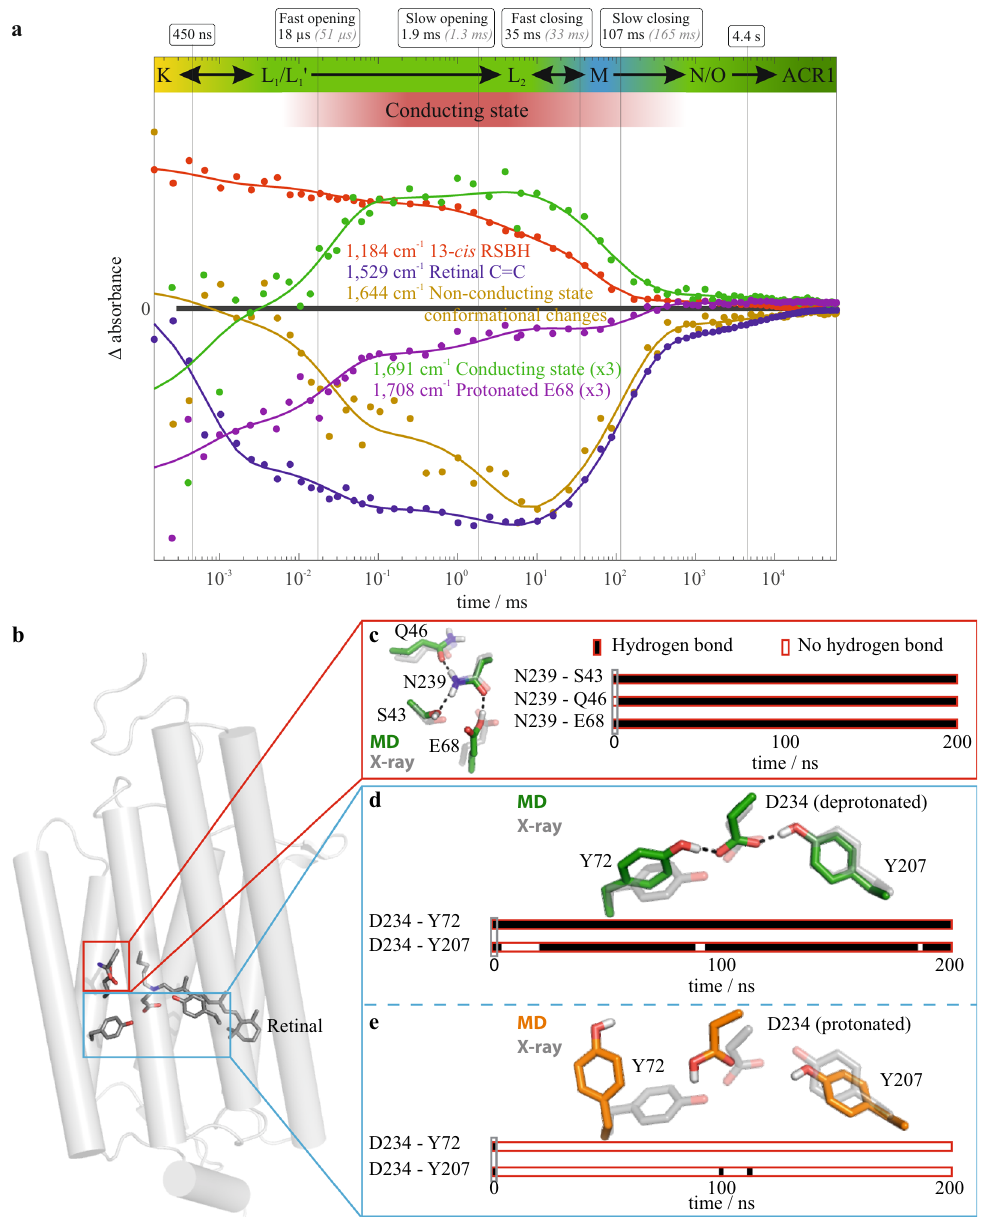
Fig. 2 Time courses of marker absorption bands of Gt ACR1. a Merged time-resolved data obtained from step-scan and rapid-scan FTIR difference spectroscopic measurements. The conducting state assignment is based on the half-lives obtained in the spectroscopic global fi t analysis (bold black numbers and vertical solid black lines) and the published electrophysiologically determined half-lives of channel opening and closing 32 (gray